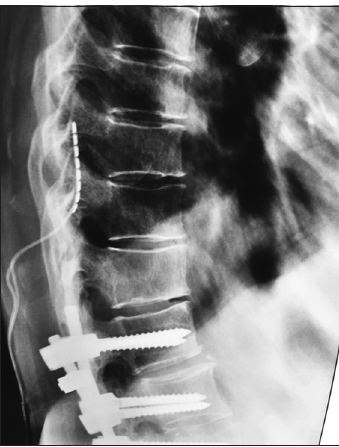
FIGURE 4. A patient diagnosed with chronic FBSS after lumbar arthrodesis underwent spinal cord stimulation implantation. The intraoperative radiography, in the sagittal plane, shows the posi- tioning of the adequate electrode in the middle of vertebral col- umn, inside the